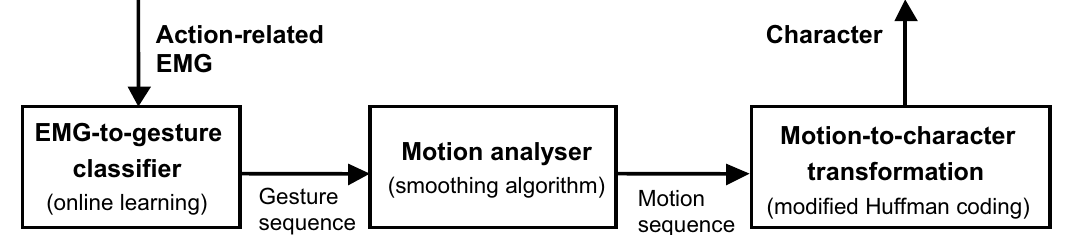
Figure 1 System